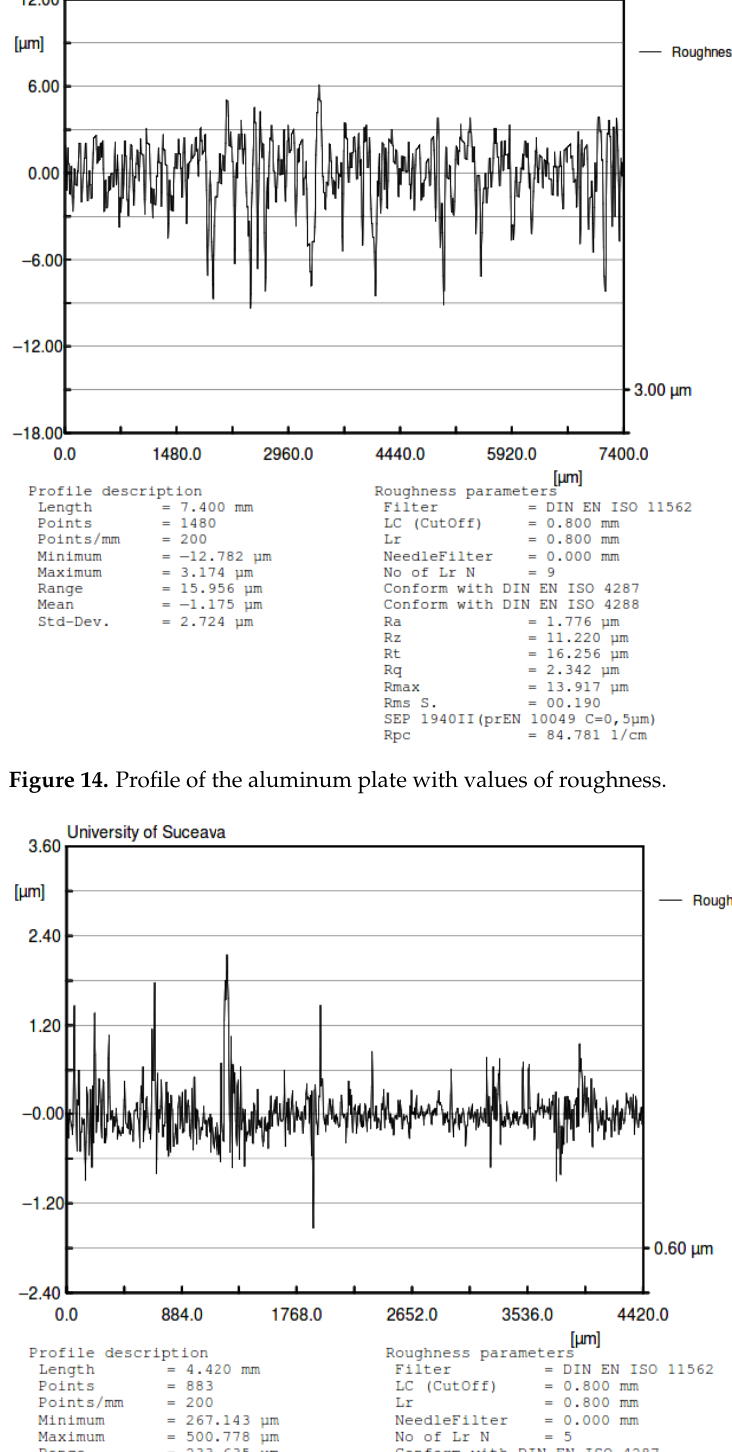
Figure 15. Profile of the steel ball with values of roughness.